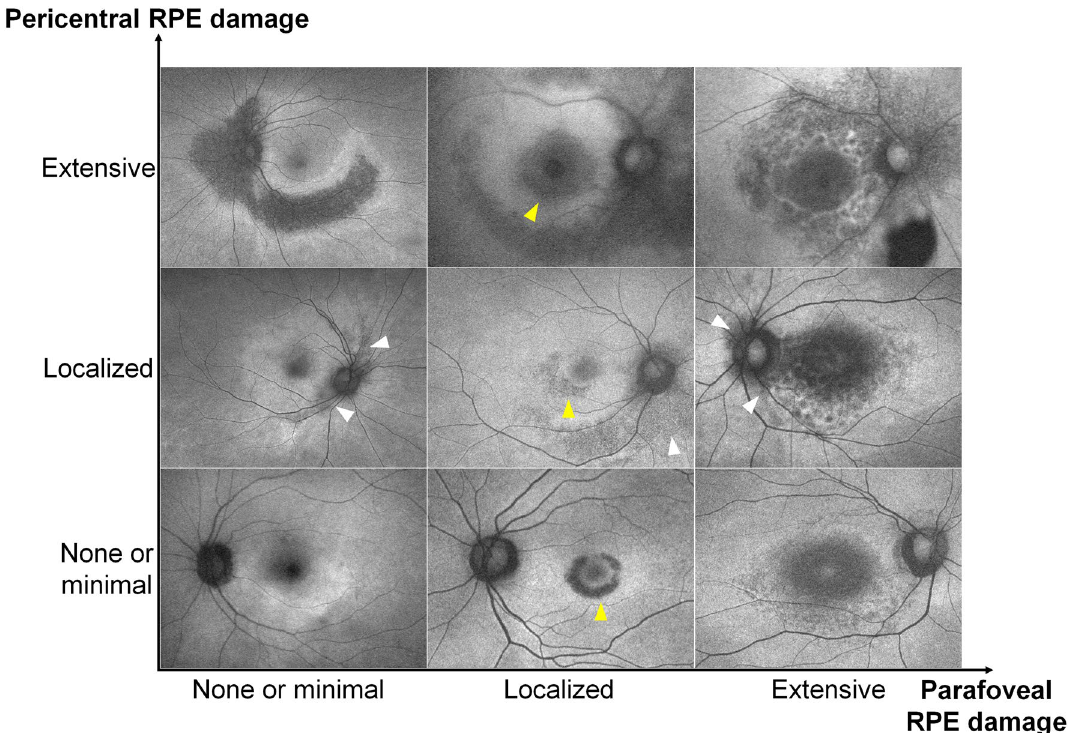
Figure 3. Representative cases of hydroxychloroquine retinopathy separated by the degrees of parafoveal (x-axis) and pericentral (y-axis) retinal pigment epithelium (RPE) defects. Parafoveal and pericentral RPE defects are commonly noted on the inferior parafoveal (yellow arrowheads) and peripapillary (nasal, white arrowheads) areas, respectively. Overall eyes (n = 146) Parafoveal involvement (n = 57) Parameters